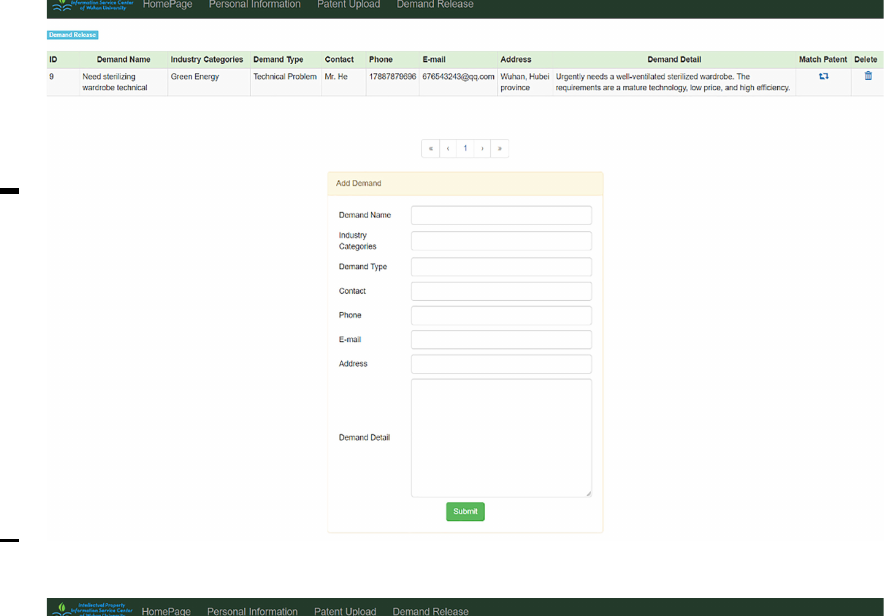
Figure 8. Submission page of technology demand